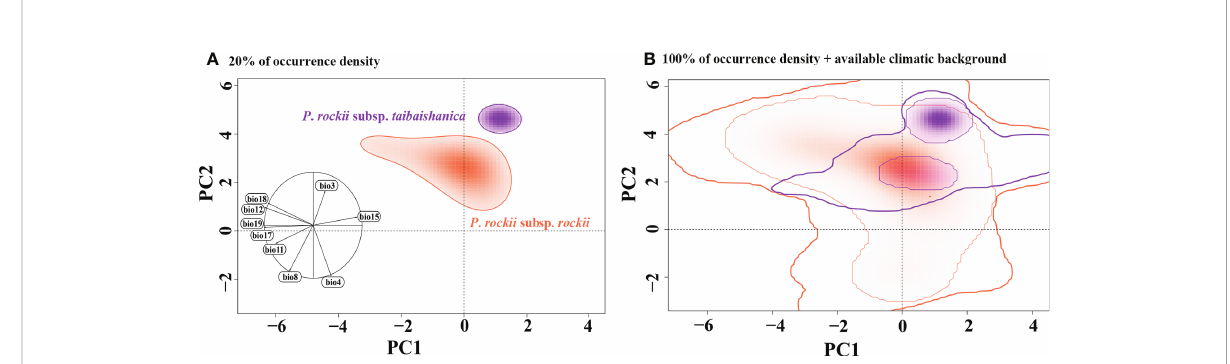
FIGURE 7 Global climatic space constructed over all background areas and realized niches of P . rockii , showing overlaps between P . rockii subsp. rockii and P . rockii subsp. taibaishanica distribution ranges, plotting a solid line representing the 20% of occurrence density (A) , and 100% of occurrence density with a thin line and 100% of available climatic background with a thick line. (B) The left graph includes the contribution and direction of each variable to the two- fi rst components of the PCA-env.